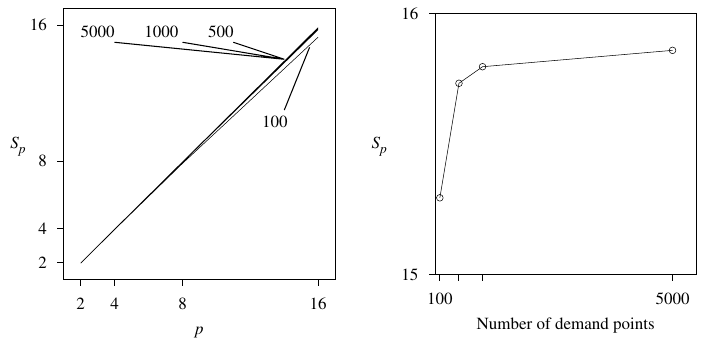
Figure 9. The speed-up of ParMOSS/OMP, obtained using different numbers of demand points, versus the number of processing units (on the left) and the speed-up, obtained using 16 processing units, versus the number of demand points (on the